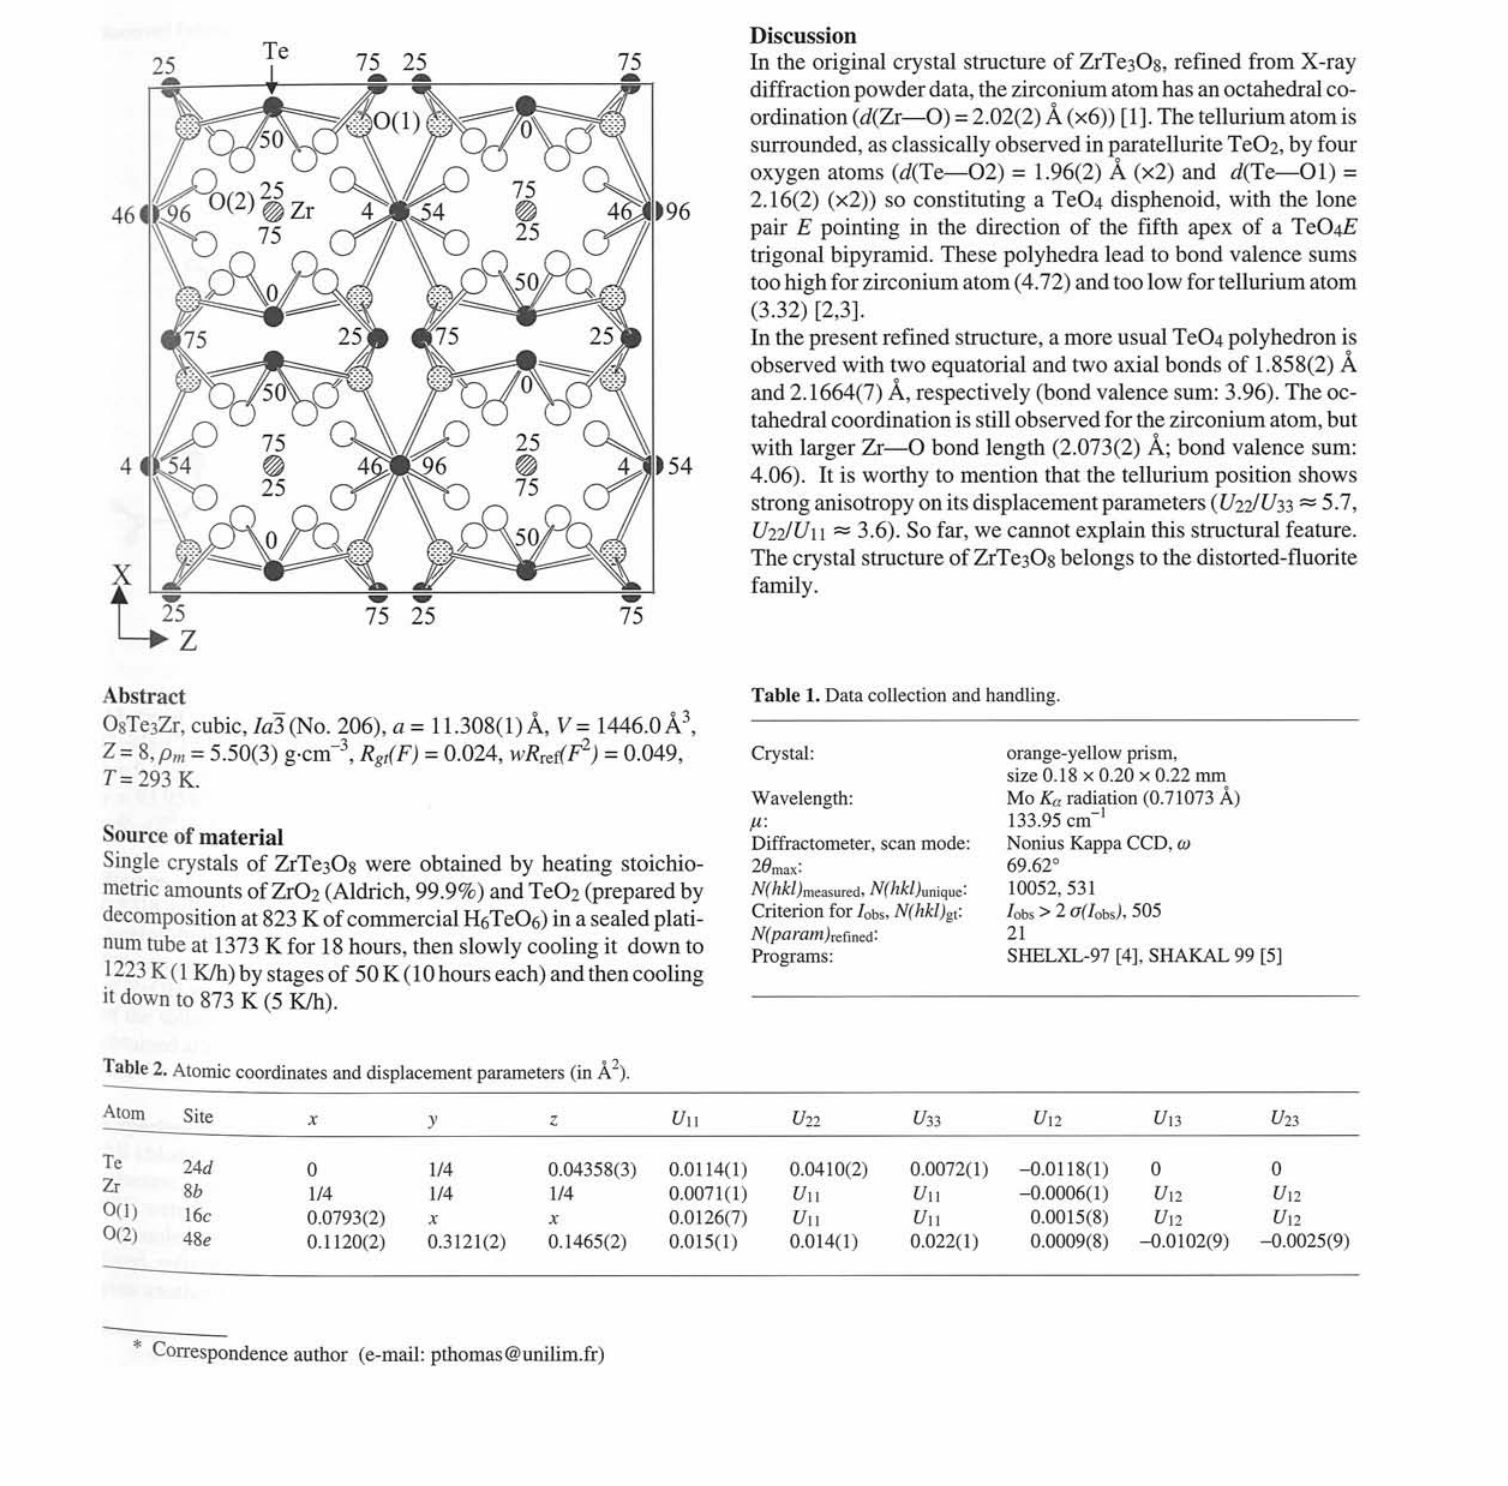
Table 2. Atomic coordinates and displacement parameters (in Â 2